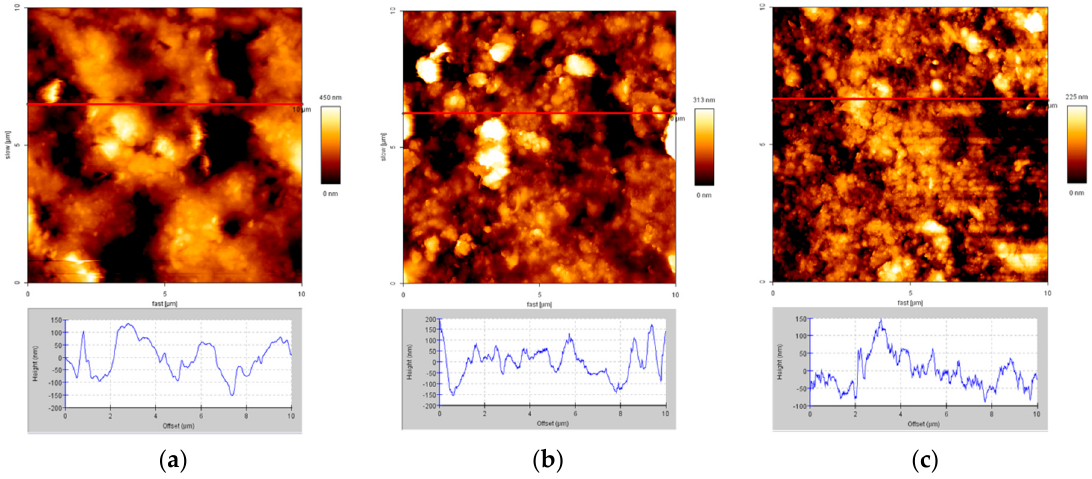
Figure 6. Atomic force microscopy (AFM) images (10 μ m × 10 μ m) and cross-section height profiles at: ( a ) The as-received rubber; ( b ) rubber treated at 200 °C with air/nitrogen = 1/4; and ( c ) rubber treated at 250 °C with air/nitrogen = 1/4.